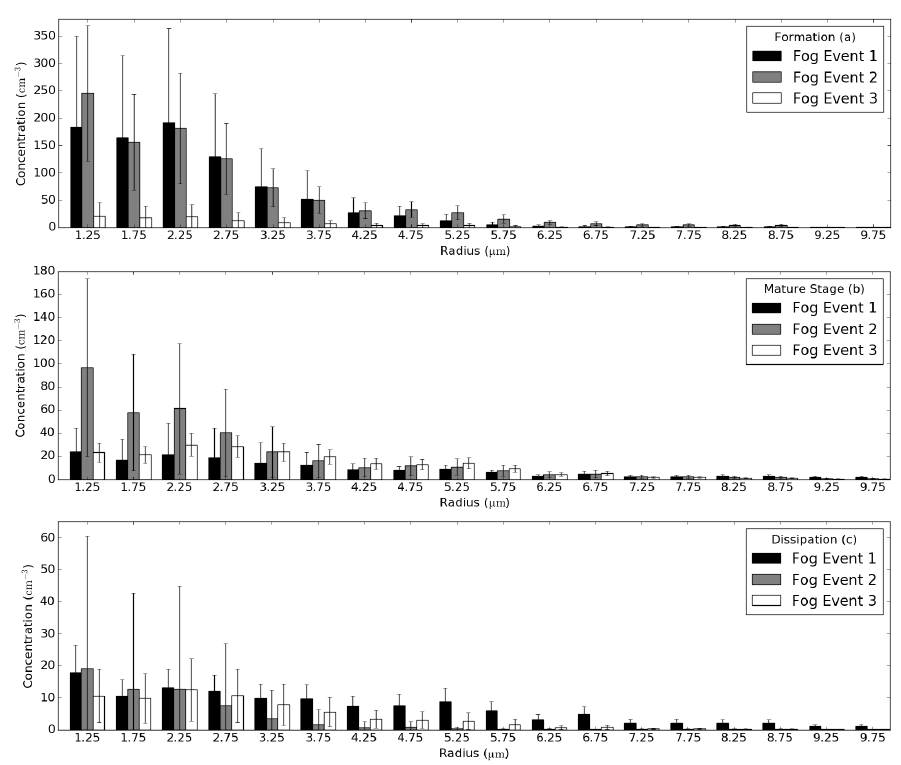
Figure 5. Absolute average spectra in ( a ) Formation, ( b ) Mature Stage and ( c ) Dissipation.